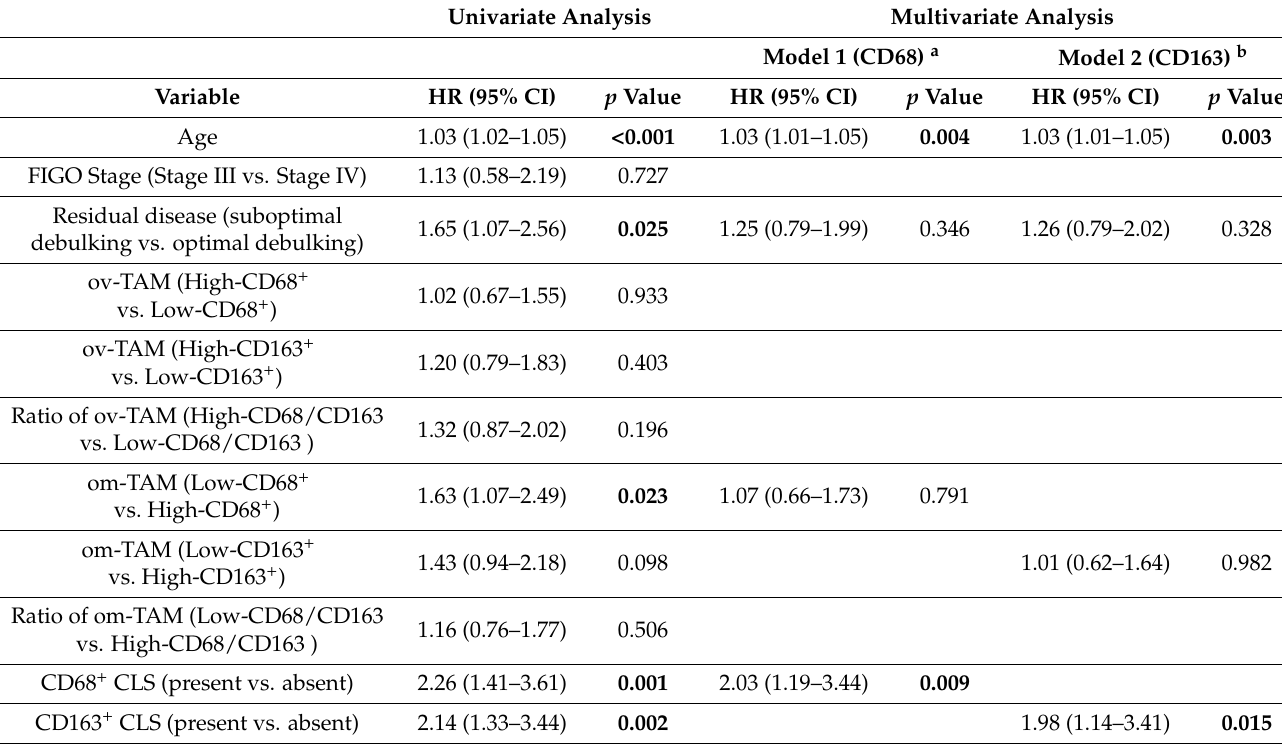
FIGO Stage (Stage III vs. Stage